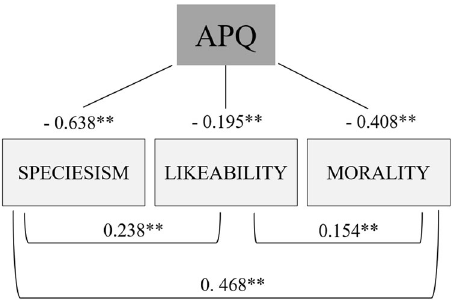
Fig. 4 A summary of the relationship between APQ attitudes, speciesism, likeability and individualising morality scores. **Indicates a signi fi cant correlation at p <